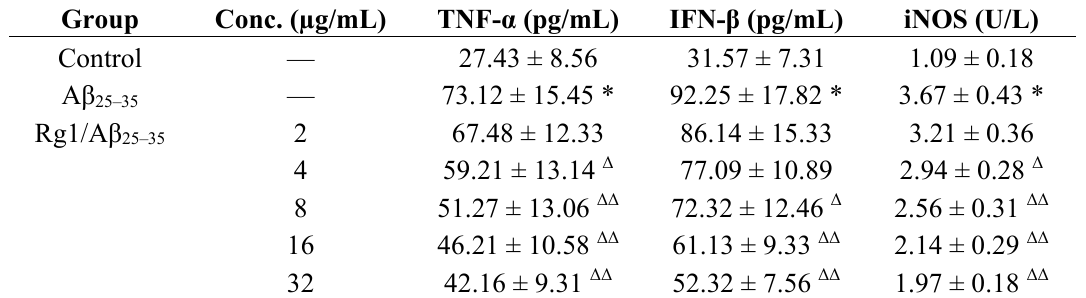
Table 1. Effects of ginsenoside Rg1 on TNF- α , IFN- β and iNOS production ( (cid:1876)̅ ± SD, n = 8). Group Conc. (µg/mL) TNF- α (pg/mL) IFN- β (pg/mL) iNOS (U/L) Control — 27.43 ± 8.56 A β — 73.12 ± 15.45 25–35